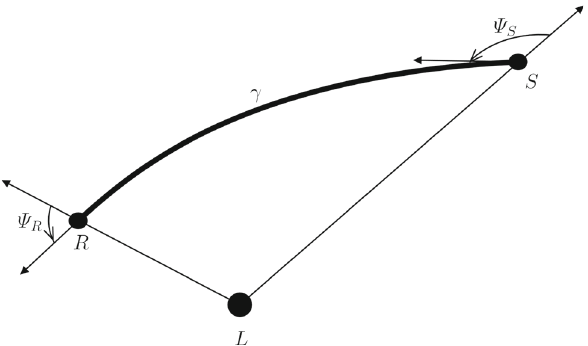
(cid:2) Fig. 1 SR is the trajectory of a particle in M (α 2 ) . The finite-distance